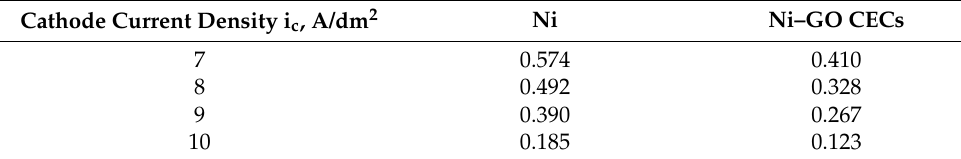
Table 3. Microhardness HV 0.05 values in MPa of nickel coatings. Table 4. Corrosion rates in mm/y of nickel coatings.